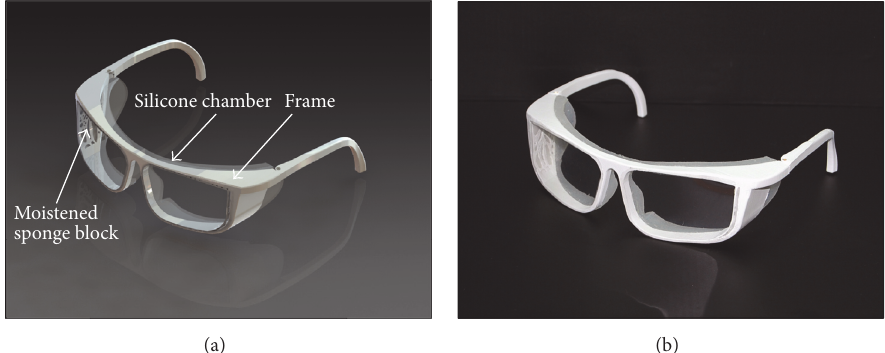
Figure 2: Rendering images and 3D printout of personalized moisture chamber spectacles. (a) Rendering images on CAD program. (b) 3D printed-out product.